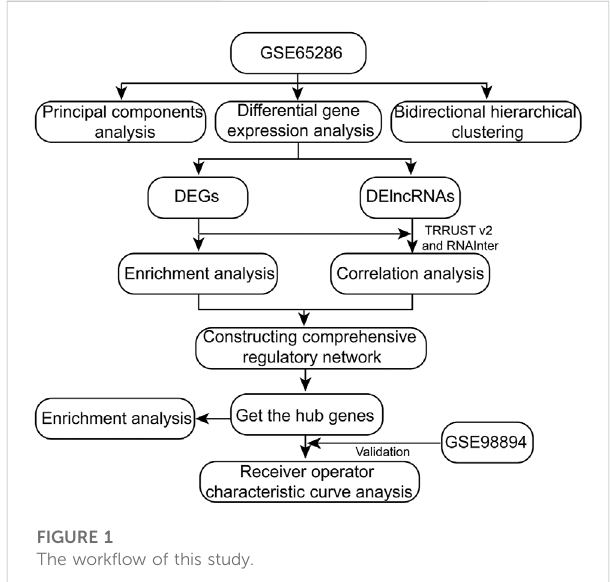
FIGURE 1 The work fl ow of this